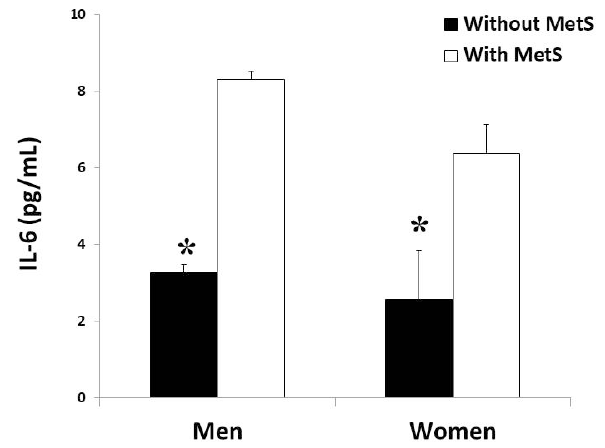
Figure 3. Interleukin 6 (IL-6) production rate in plasma (men and women) in the study, classified according to metabolic syndrome. Results are presented as mean ± SEM. Significant effects of metabolic syndrome were found in both groups by two-way ANOVA. *Differences in means between participants without and with MetS.